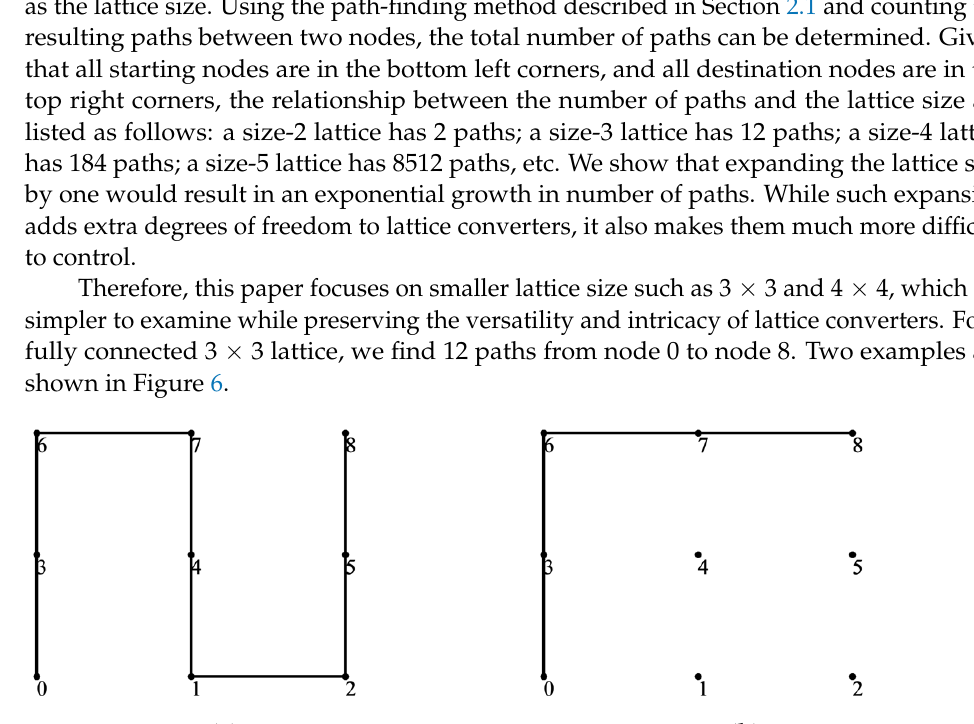
Table 1. Classification of 3 × 3 lattice paths from node 0 to node 8 according to Path Size.